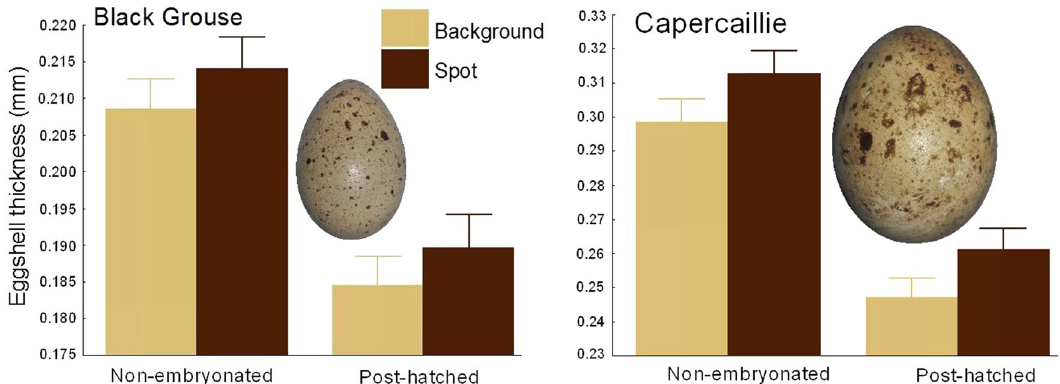
Figure 1. Overall eggshell thickness (average ± 95% CI) measured over the entire longitudinal section of the egg (from the sharp pole to the blunt one): both non-embryonated and post-hatched shells of the cryptic eggs of Black Grouse Tetrao tetrix and Capercaillie Tetrao urogallus (depicted as miniatures) are always significantly thinner in the background colour shell region than in the adjacent pigmented spot. Note : The shells of all the Black Grouse and Capercaillie eggs were respectively − 2.67% and − 5.34% thinner in the background colour than the pigment spot region. In each case, the t -test for paired comparisons showed highly significant differences with the exact P value equal to 0; see Table S1 for the statistical